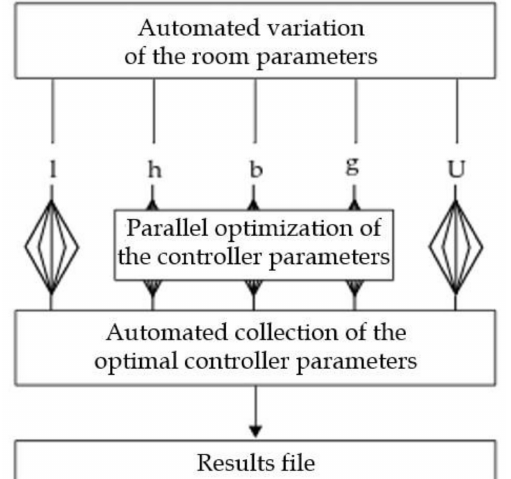
Figure 9. Steps to optimize the controller parameters (Supplementary